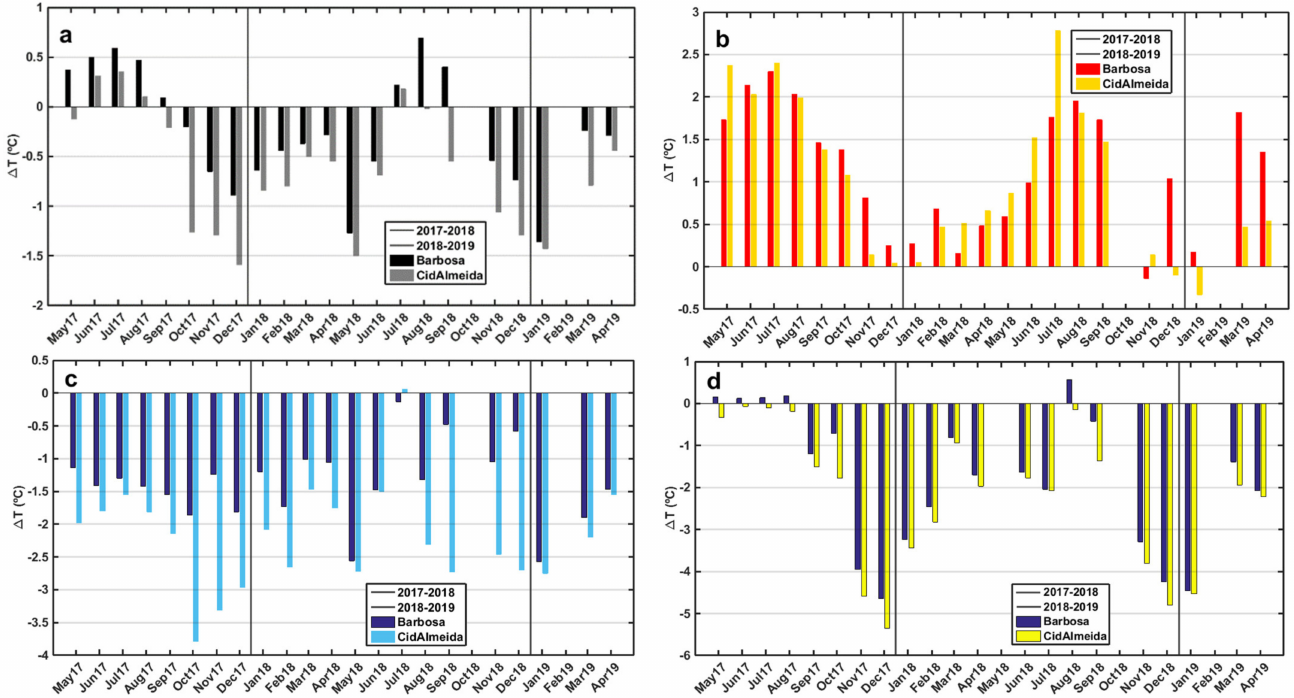
Figure 3. Monthly temperature differences between onshore stations (Barbosa and Cid Almeida) and platform station (Montante) for: ( a ) mean air temperature; ( b ) maximum air temperature; ( c ) minimum air temperature. ( d ) Monthly difference between air temperature in onshore stations and water temperature at 0.5 m depth (in Montante station). Grey vertical lines separate the years 2017, 2018 and